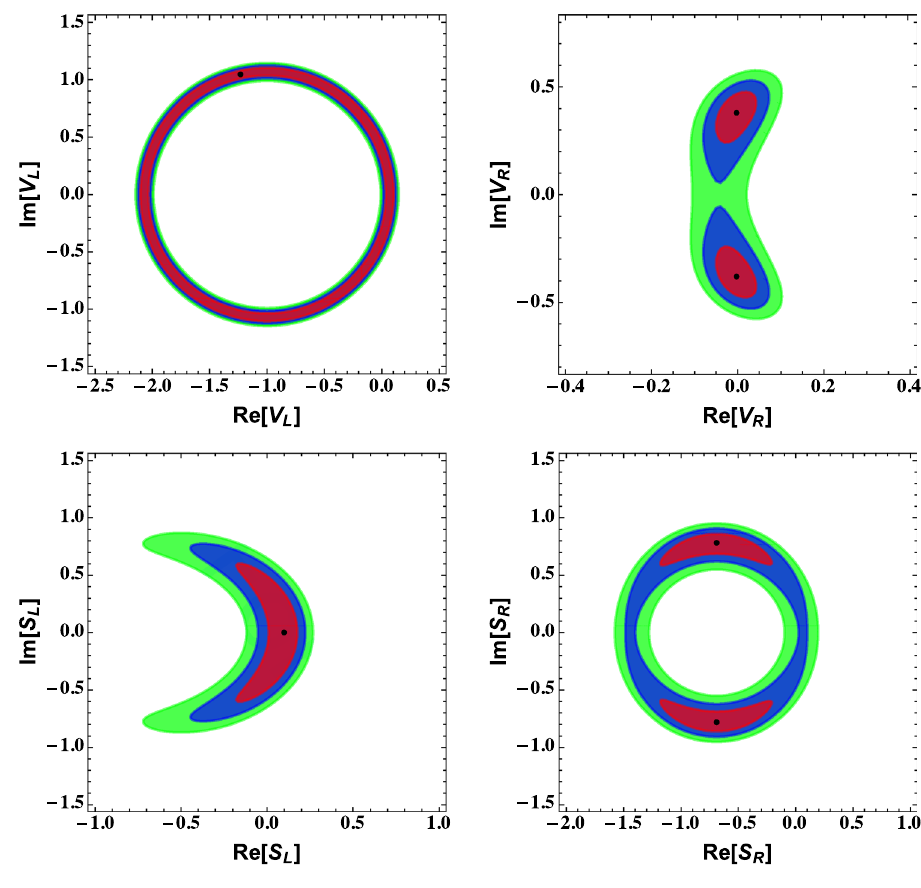
right panel) coefficients of b → c mediated decay